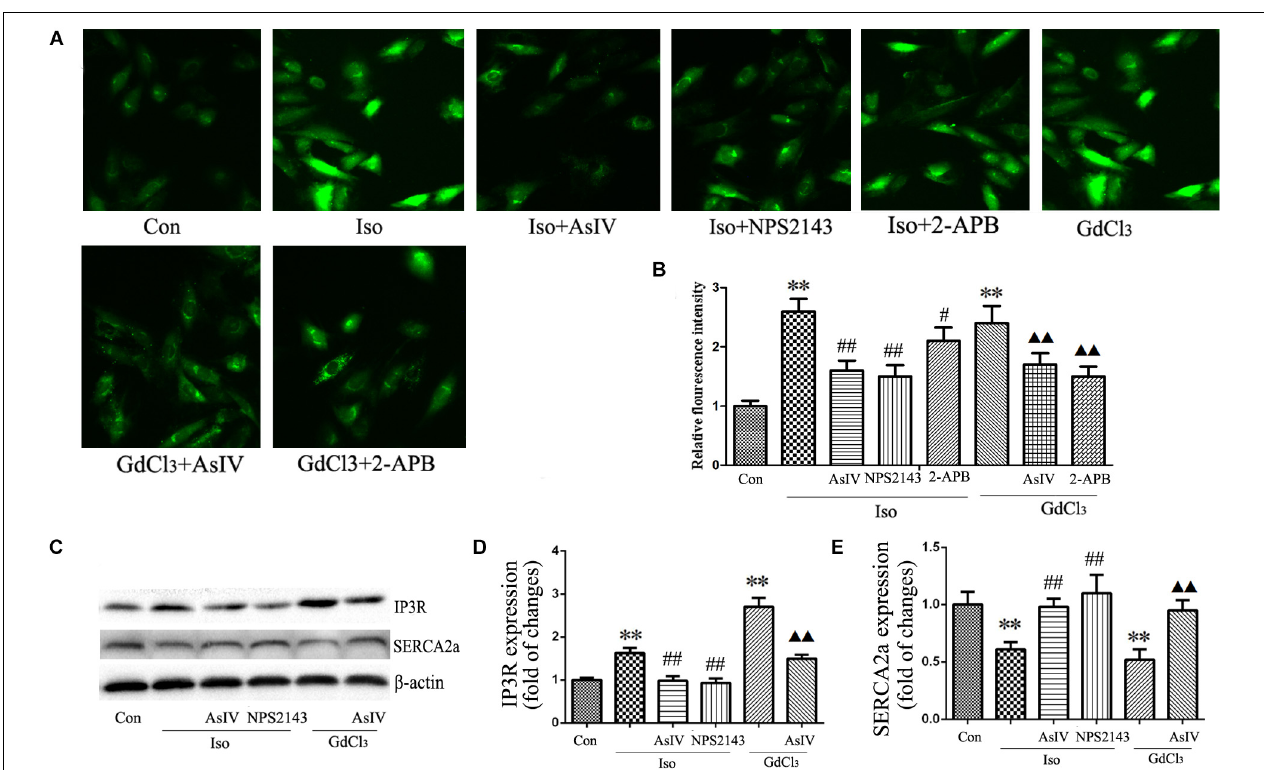
FIGURE 6 | AsIV regulated [Ca 2 + ] i induced by Iso and GdCl 3 . (A) Changes in the intensity of fluorescence of [Ca 2 + ] i were recorded with a laser scanning confocal microscope under different treatment conditions. (B) The bars represent the fluorescence relative to that of the controls. (C–E) IP3R and SERCA2a protein expression assayed by western blot analysis in myocardial tissue. Data are expressed as mean ± SEM, n = 4. ∗∗ P < 0.01 vs. Con group, ## P < 0.01 vs. Iso group, and (cid:78) P < 0.05, (cid:78)(cid:78) P < 0.01 vs. GdCl 3